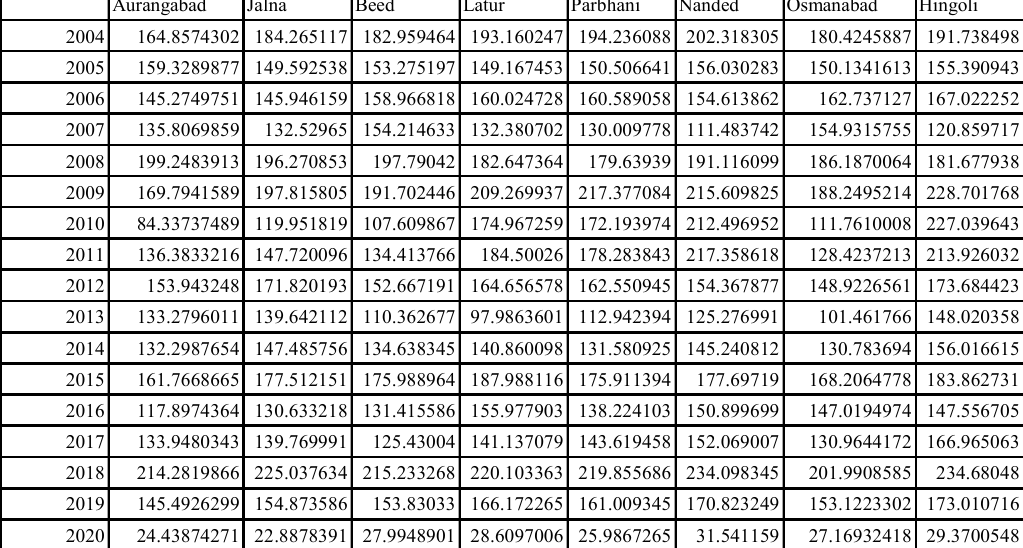
Table 6: Percentage of drought as compared to 17 year means of respective